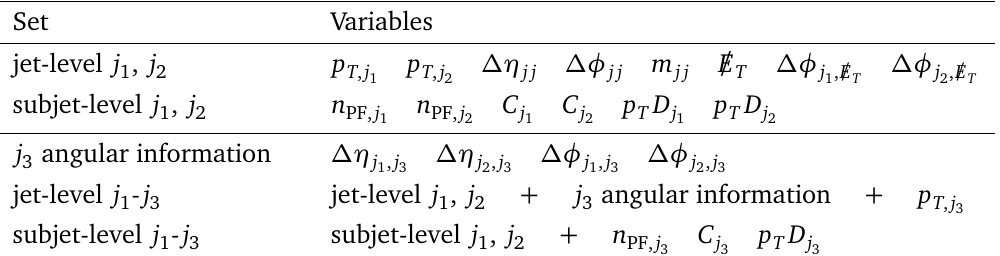
Table 1: Sets of variables used for the BDT analysis. Variables with the subscript j j refer to the two tagging